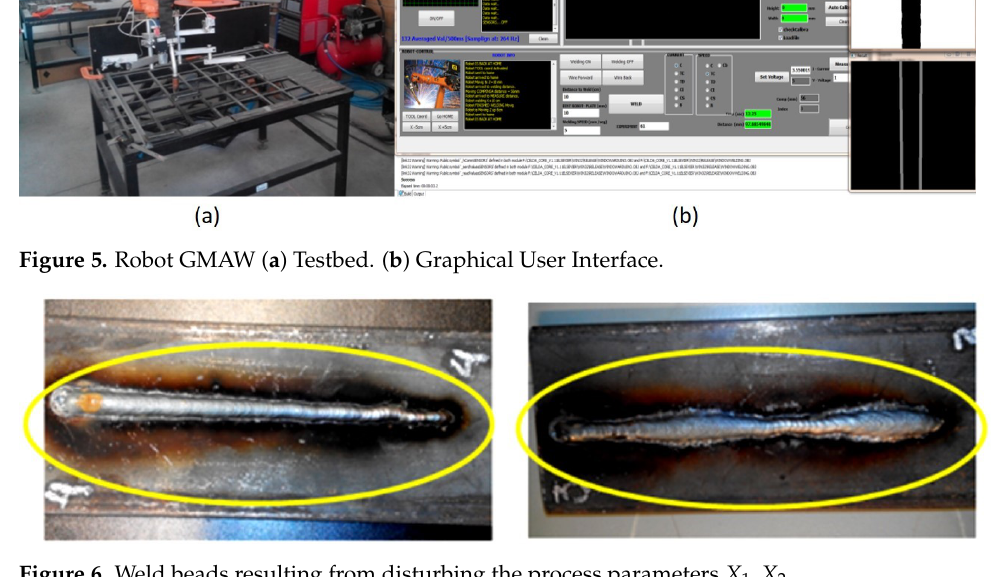
Figure 6. Weld beads resulting from disturbing the process parameters X 1 , X 2 Table 3. Experimental parameters for SVM and D 2 .